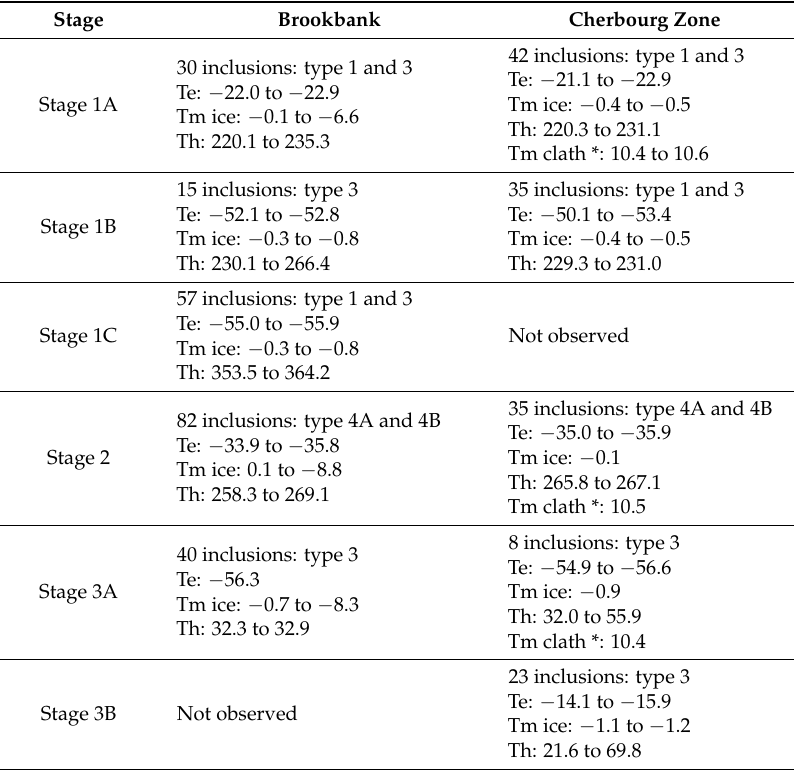
Table 2. Summary of fluid inclusion